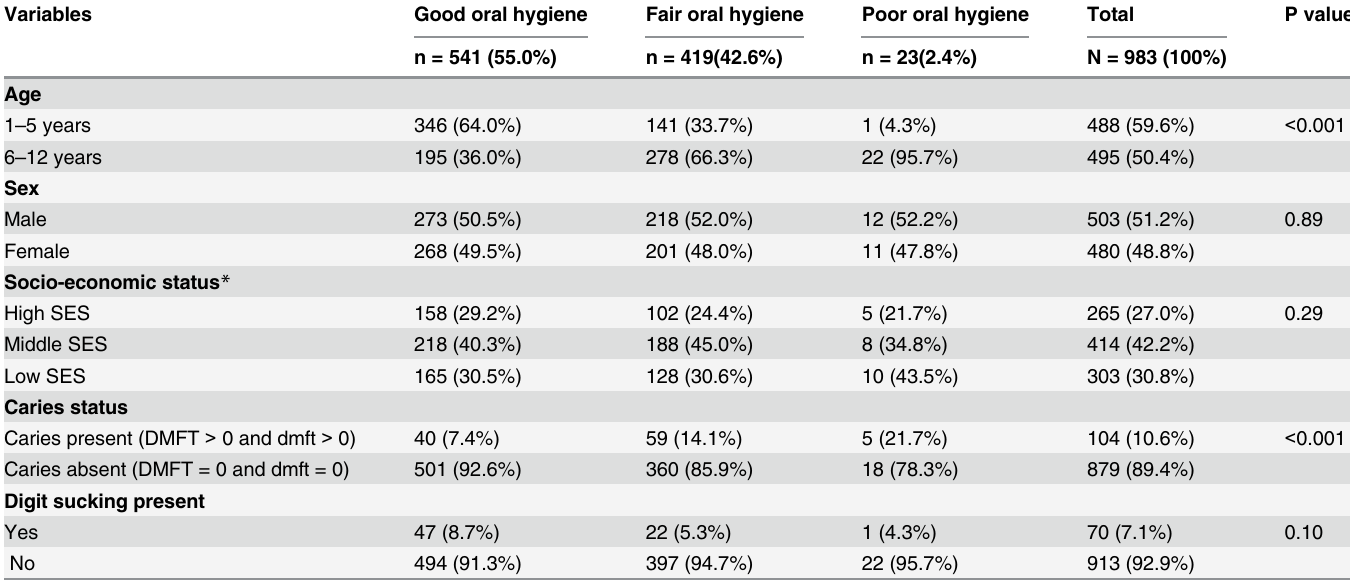
Table 3. Oral hygiene profile of study participants (N =